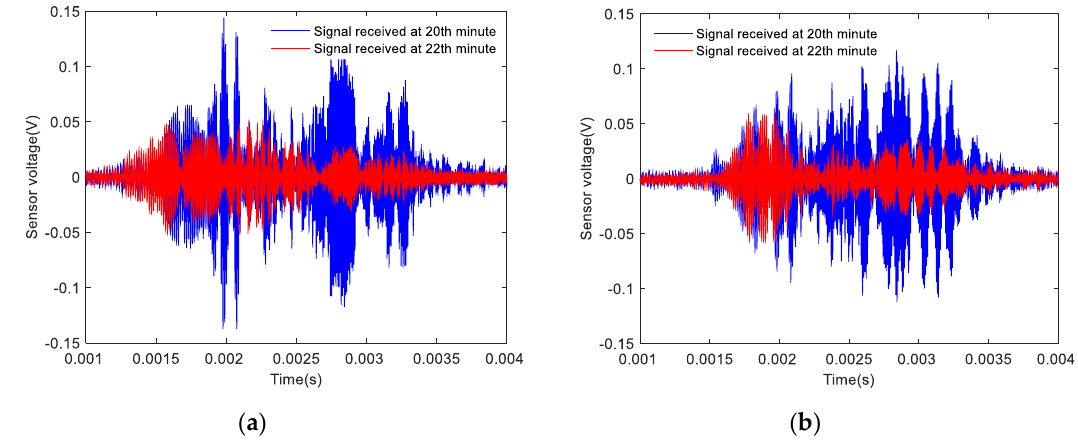
Figure 18. Time-domain signal diagram of Composite specimen III before and after damage: ( a ) Measured signal by SA 3; ( b ) Measured signal by SA 4.